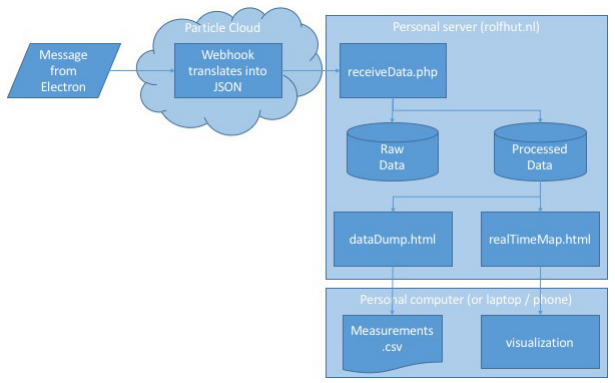
Figure 3. The flow of data once it leaves the particle electron. The electron sends the measurements as a comma-separated message to the particle cloud. A webhook running on the particle cloud parses the raw message into a JSON message that is posted to a .php file on the personal server of the main author. This file adds the data to two databases: one to store all raw messages, and one that parses the message into the individual measurements. Two .html files can be called upon by users. DataDump.html transforms the database into a comma-separated file for downloading, and realTimeMap.html shows the last known locations of the drifters for real-time localiza- tion during the field campaign. All software is available on GitHub (Hut, 2018).